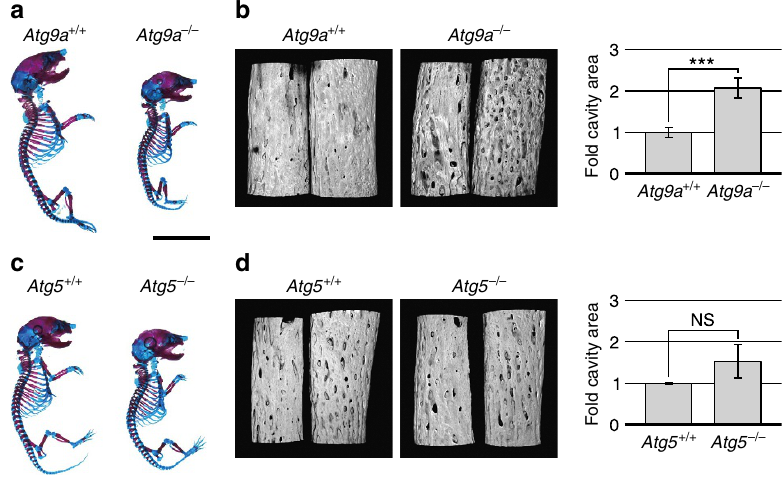
Figure 6 | Bone morphology in Atg9a KO mice. ( a ) Newborn Atg9a KO mice were smaller than newborn wild-type mice, but did not display obvious skeletal dysplasia. Transparent specimens of Atg9a KO ( Atg9a (cid:2) / (cid:2) ) and control ( Atg9a þ / þ ) newborn pups were stained by Alcian Blue and Alizarin Red S. Scale bar, 10mm. ( b ) Porosity of the bone surface in Atg9a KO mice. Forelimb zeugopods of a newborn Atg9a KO ( Atg9a (cid:2) / (cid:2) ) pup and a control ( Atg9a þ / þ ) pup were examined by laser scanning confocal microscopy using Alizarin Red S fluorescence, followed by three-dimensional-rendering of the z-stack images. Bar graphs display quantification of the cavity area in the forelimb zeugopods of Atg9a (cid:2) / (cid:2) and Atg9a þ / þ pups (as fold changes). Because there was a significant difference of bone morphogenesis between pups from different mothers, we normalized the cavity area ratio by that of wild-type littermates (the mean cavity area in wild-type littermates was set as 1). Data are represented as the mean ± s.d.; n ¼ 5 for Atg9a þ / þ pups and n ¼ 3 for Atg9a (cid:2) / (cid:2) pups. *** P ¼ 0.0001 for comparison between Atg9a (cid:2) / (cid:2) and Atg9a þ / þ pups by the two-tailed Student’s t -test. ( c ) Transparent specimens of a newborn Atg5 KO ( Atg5 (cid:2) / (cid:2) ) pup and a control ( Atg5 þ / þ ) pup. Scale bar, 10 mm. ( d ) In the Atg5 KO pup, the bone surface does not display remarkable changes compared with that of the control pup. The same analysis as in b was performed for the forelimb zeugopods of newborn Atg5 KO ( Atg5 (cid:2) / (cid:2) ) pups and control ( Atg5 þ / þ ) pups. n ¼ 3 for Atg5 þ / þ pups and n ¼ 5 for Atg5 (cid:2) / (cid:2) pups. NS: P ¼ 0.07 for comparison between Atg5 (cid:2) / (cid:2) and Atg5 þ / þ pups by the two-tailed Student’s t -test. There was no significant difference between Atg5 (cid:2) / (cid:2) and Atg5 þ / þ pups.